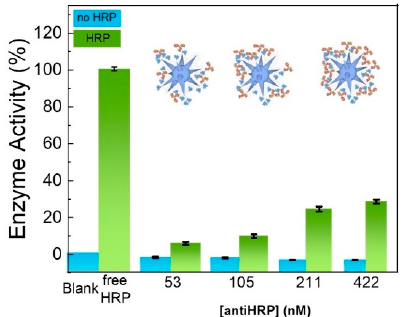
Figure 5. Enzymatic assays for bioconjugates. “Blank”: assay without HRP. “Free-HRP”: assay with the same amount of free HRP as added to the bioconjugates. The enzymatic activities for bioconjugates with and without HRP confirmed the positive recognition from the AuNS–MBA-immobilized anti-HRP antibody.